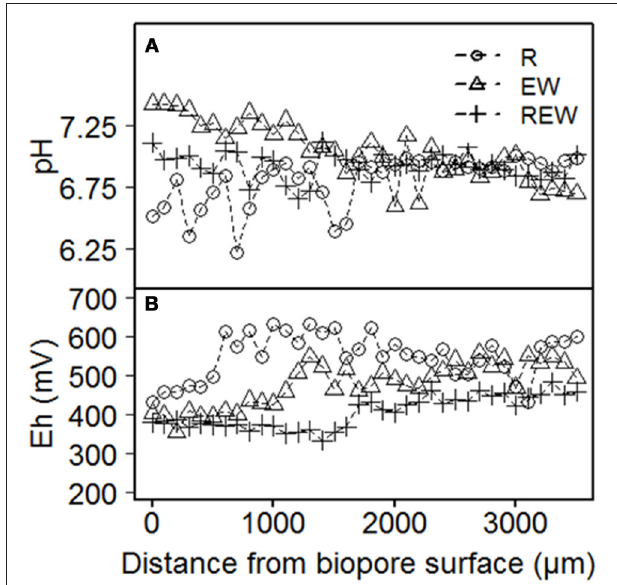
FIGURE 7 | Exemplary results of (A) pH and (B) Eh of biopore walls [pore colonized by root (R), colonized by L. terrestris (EW) and (REW) equal to R but followed by colonization of L. terrestris ]. Samples drained to 9 m = − 1